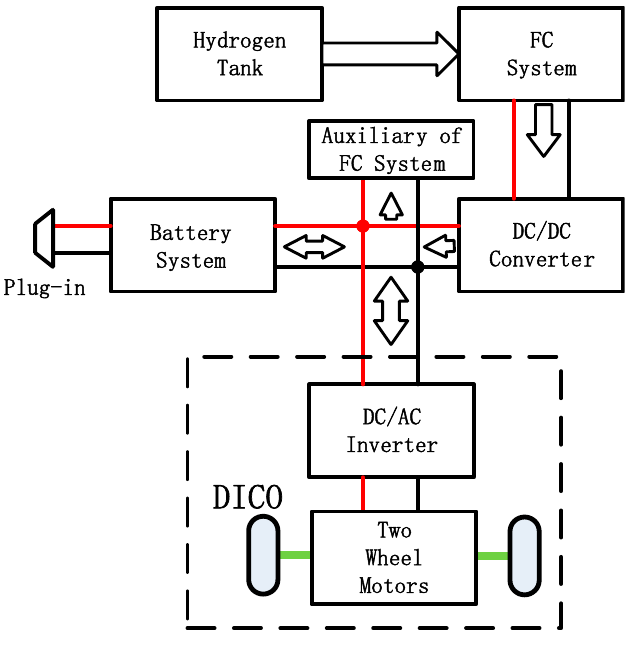
Figure 1. Powertrain structure schematic.